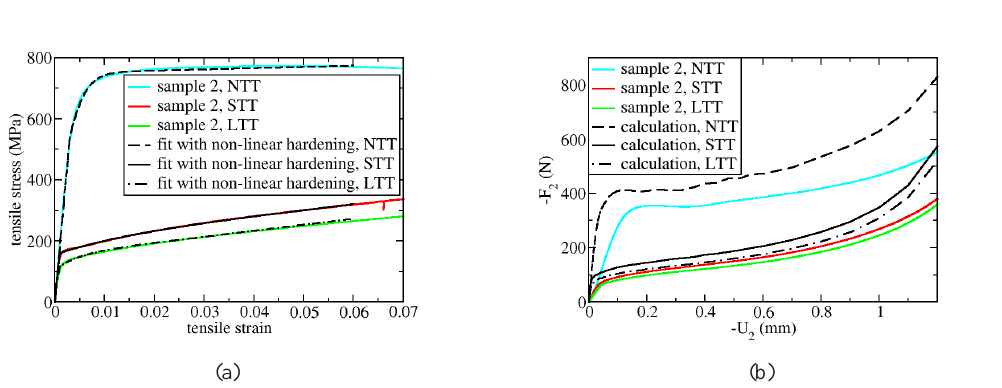
Fig. 3. Influence of the treatment on a) the longitudinal strength of the tubes in tension b) the transversal strength of the tubes in compression. F 2 and U 2 are the force and the displacement transversally to the axis of the